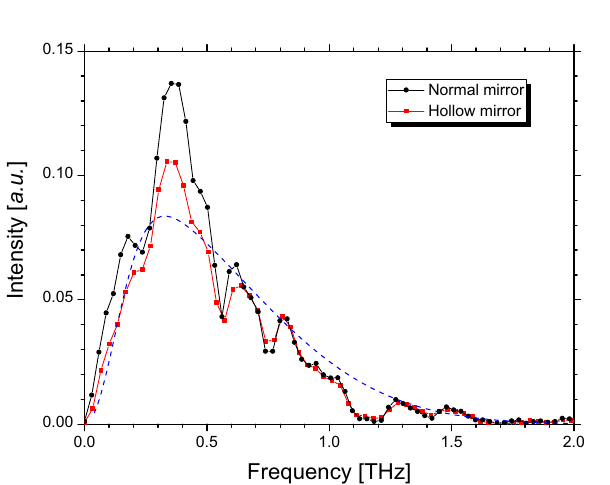
Figure 3. Measured power of CER beam. Black and red lines represent CER power measured with normal and hollow concave mirrors, respectively.